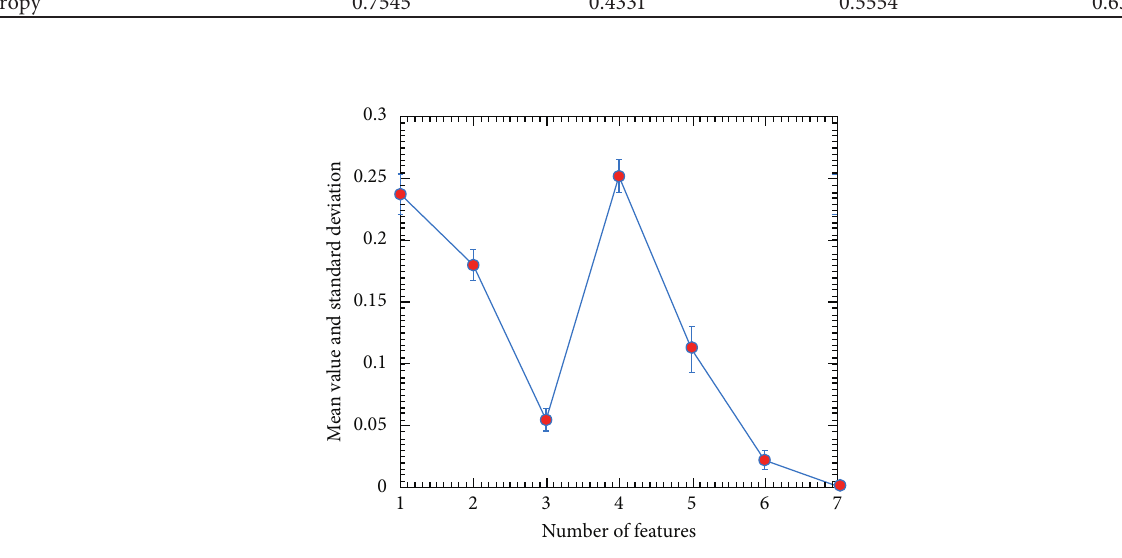
Figure 5: The degree of importance of the energy entropy